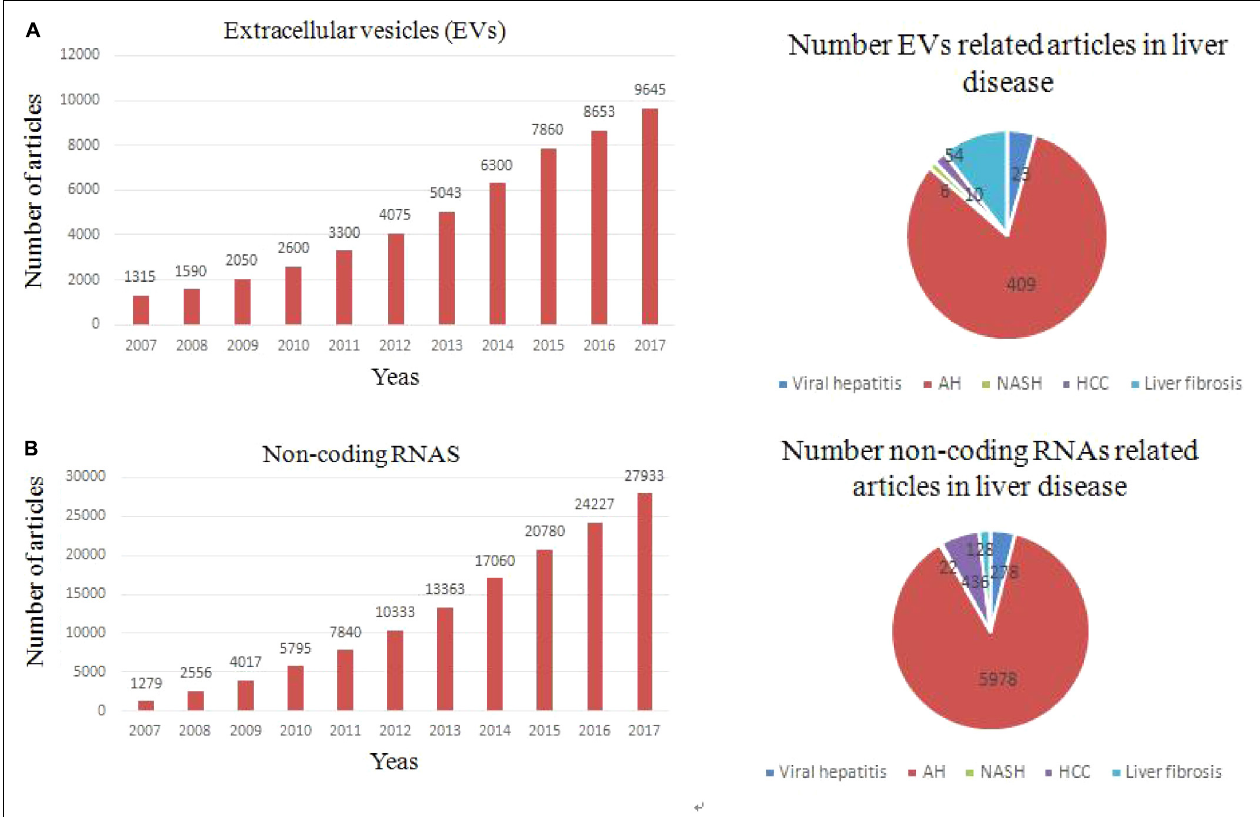
FIGURE 2 | Trends of non-coding RNAs and EVs related articles, since 2000. (A) Exponential growth in the number of EVs-related articles (upper left panel) and number of articles related to each type of liver fibrosis (upper right panel). (B) Exponential growth in the number of non coding RNAs-related articles and total number of articles related to each liver